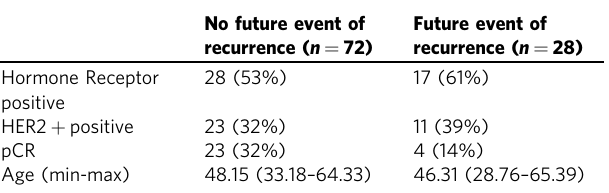
Table 1 Selected patient characteristics for discovery